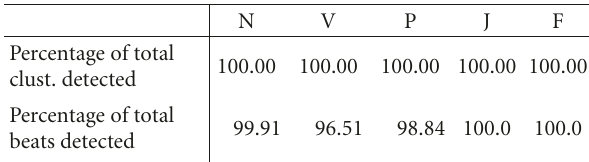
Table 3: Summary comparison of detection through symboliza- tion to cardiologist supplied labels for the MGH/MF waveform database. The labels of the columns match those in Table 2 with J = junctional premature